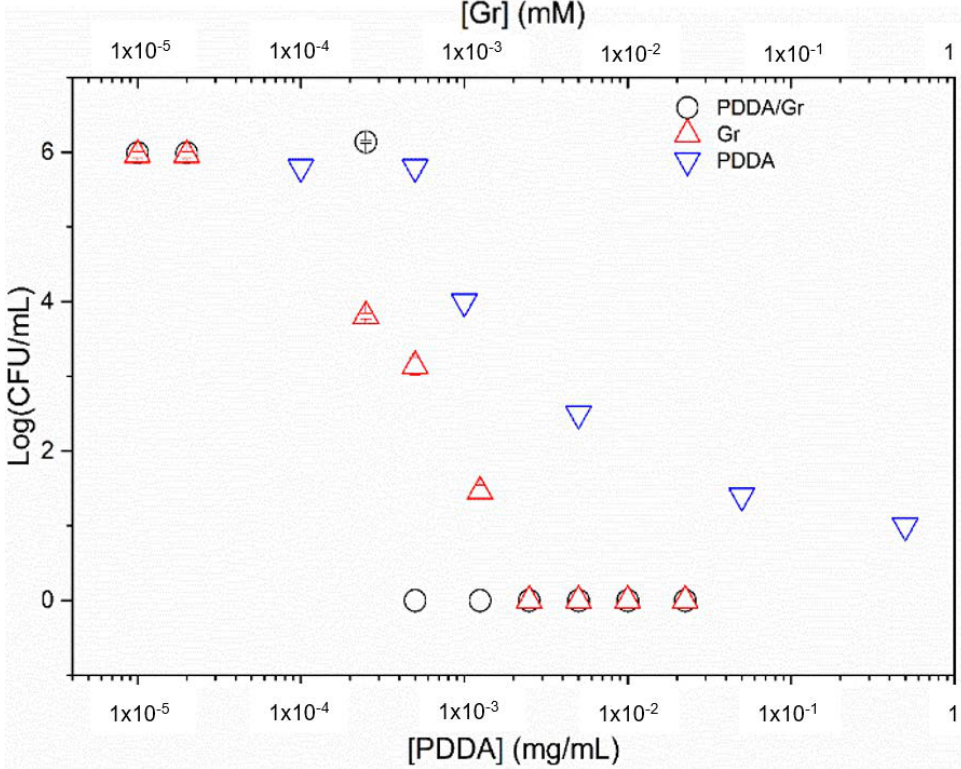
Figure 9. Cell viability of C. albicans (10 6 CFU/mL) after interacting for 1 h with gramicidin (Gr) nanoparticles (NPs), poly (diallyl dimethyl ammonium chloride) (PDDA) solutions, or Gr NPs/PDDA dispersions over a range of Gr and/or PDDA concentrations. Data for cell viability in the presence of PDDA only, over a range of PDDA concentrations, were reproduced from